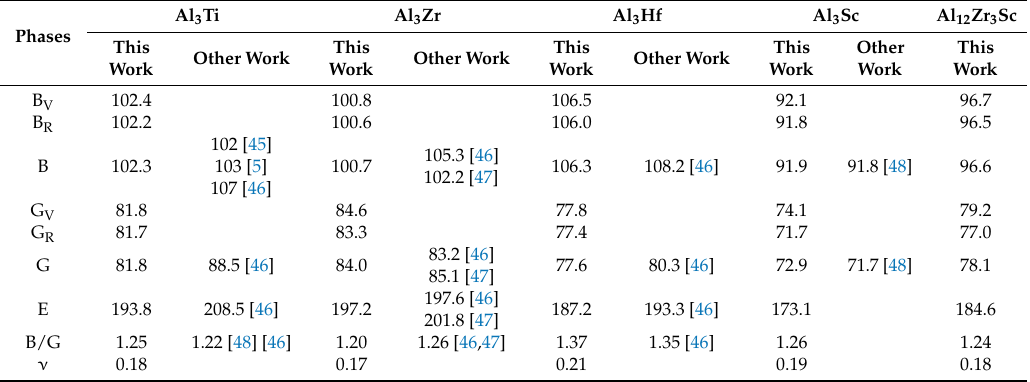
Table 3. Calculated bulk modulus B ( GPa ), shear modulus G ( GPa ), Young’s modulus E ( GPa ), B/G , Poisson’s ratio ν , and Debye temperature Θ D ( K ) of the Al 3 TM (TM = Ti, Zr, Hf, Sc)